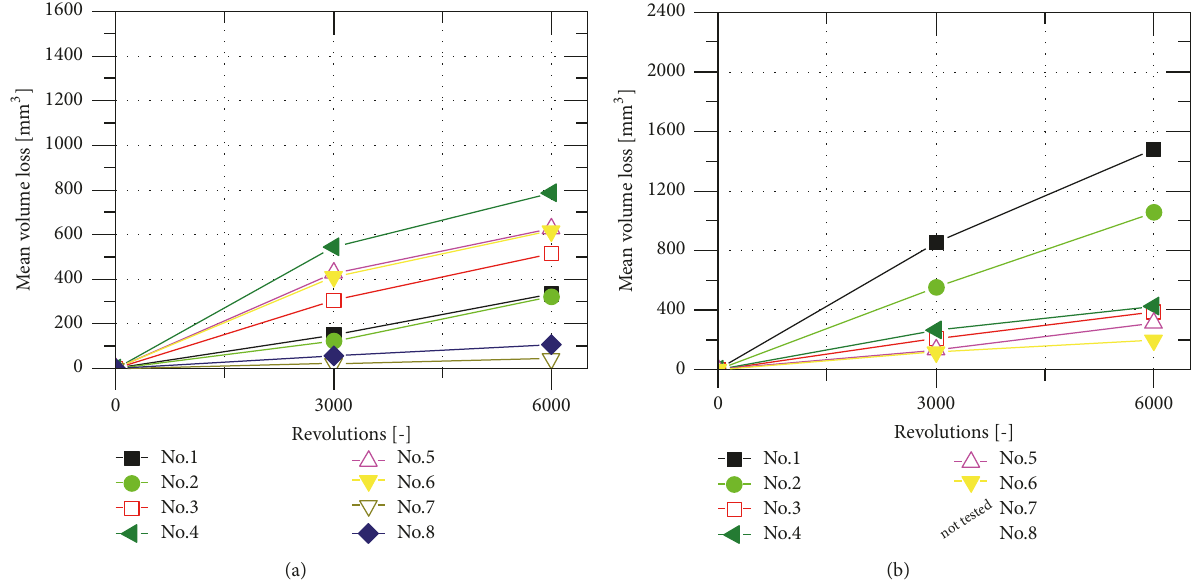
Figure 10: Comparison of the mean loss of volume with steel friction wheel (a) and rubber friction wheel